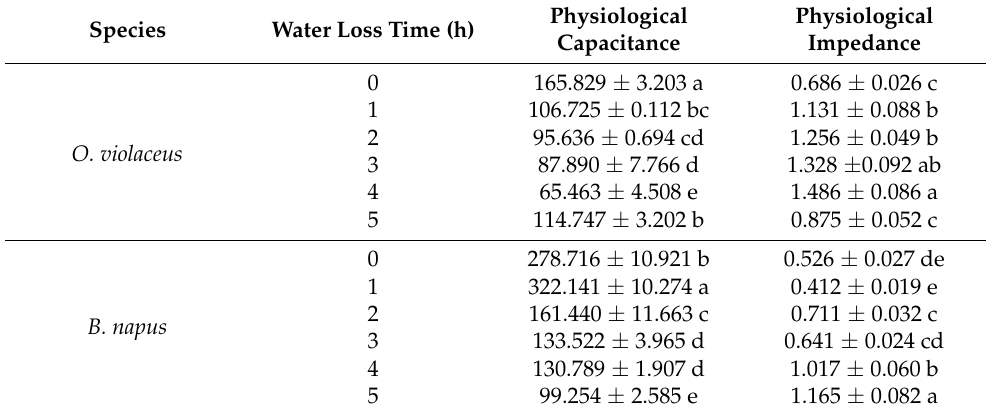
Table 5. Leaf physiological capacitance (CP, pF) and impedance (Z, M Ω ) at different dehydration